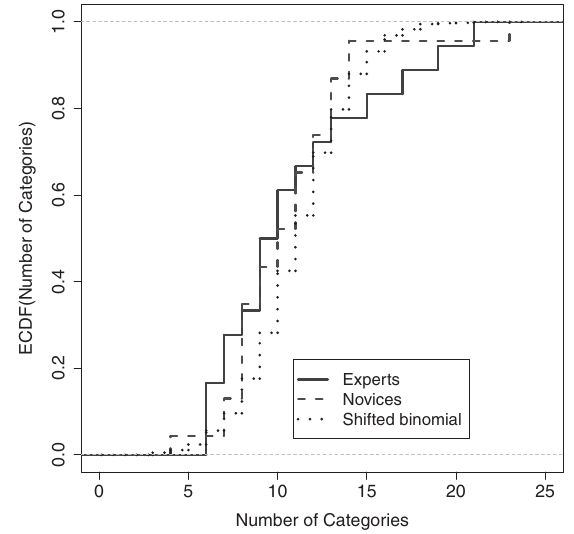
FIG. 3. Distribution of number of categories. Here we see the ECDFs of the number of category distributions for experts and novices separately. The faculty set is displayed using the dashed curve and the novice set is displayed using the dotted curve. We also compare these distributions to a sample ( N ¼ 1000 ) shifted binomial distribution with probability (cid:2) ¼ 0 : 204 . A Kolmogorov-Smirnov test comparing these two distributions suggests that expert and novice categorizations are not distin- guishable based on category number ( p ¼ 0 : 4793 ), and both are well approximated by the same shifted binomial